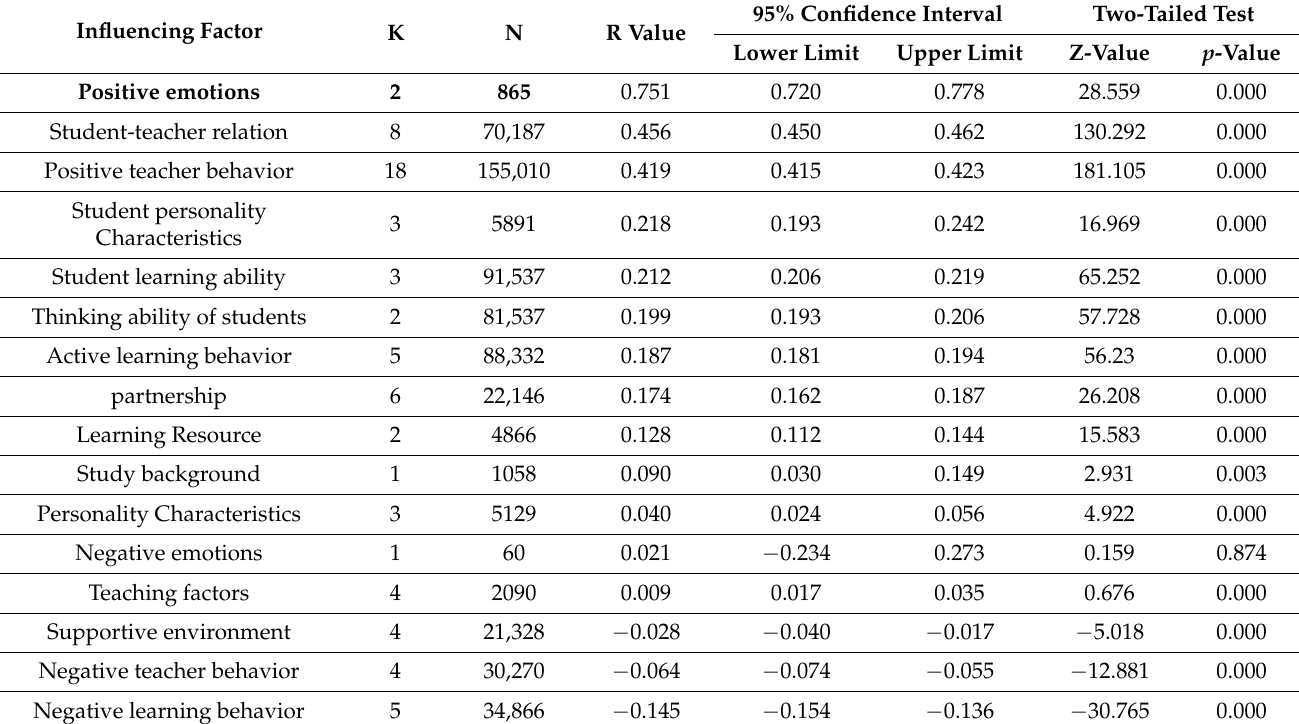
Table 4. Specific results of meta-analysis on factors affecting students’ learning